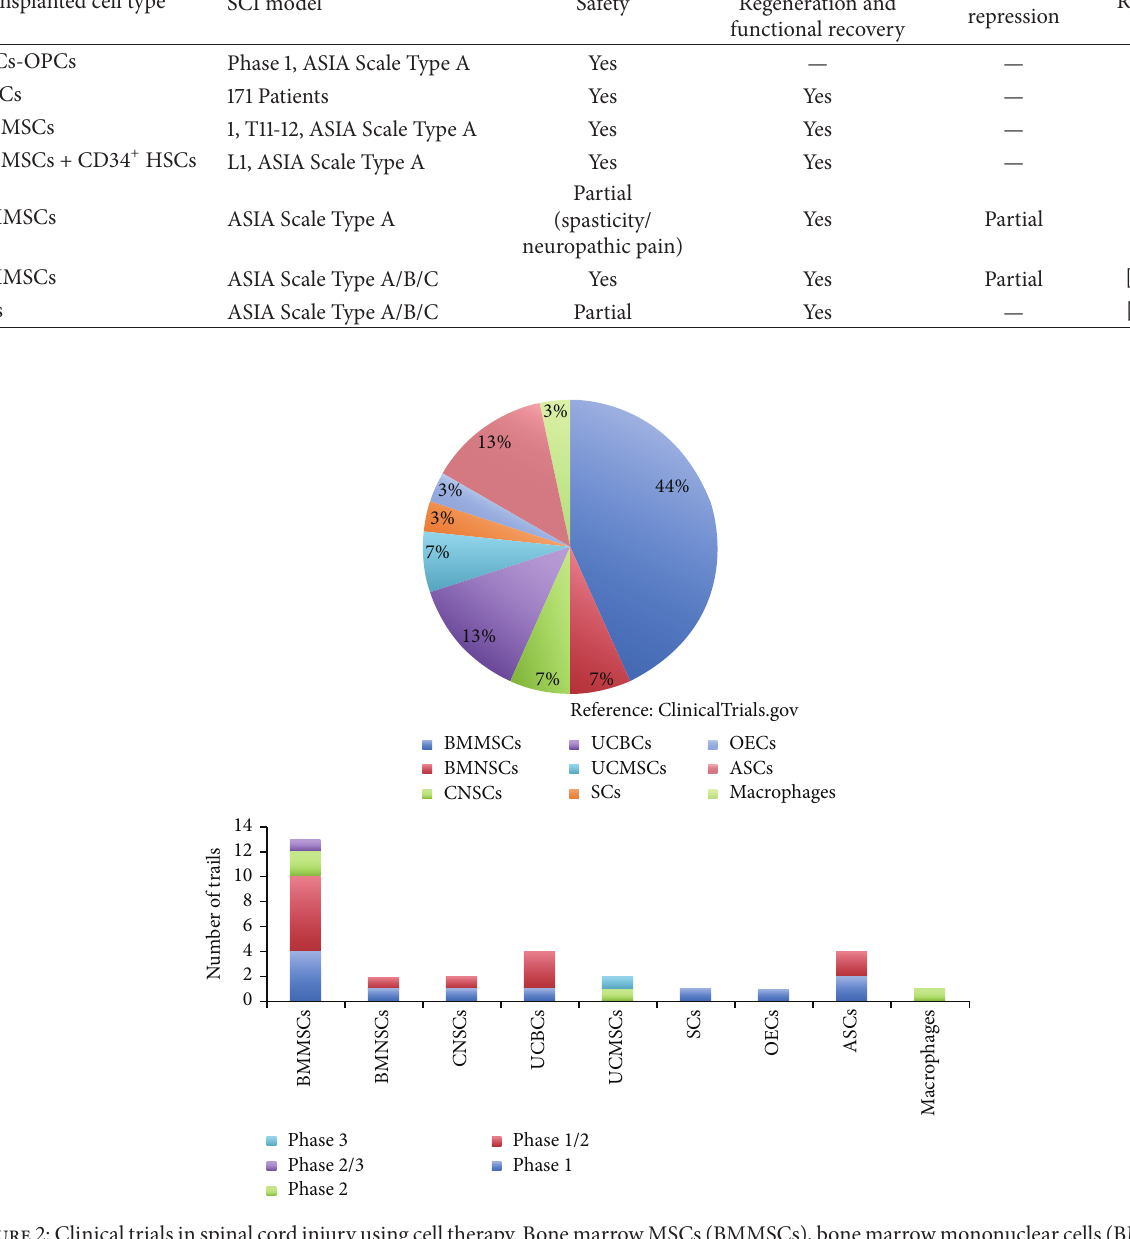
Figure 2: Clinical trials in spinal cord injury using cell therapy. Bone marrow MSCs (BMMSCs), bone marrow mononuclear cells (BMNSCs), central nervous system cells (CNSCs), umbilical cord blood cells (UCBCs), umbilical cord blood MSCs (UCBMSCs), Schwann cells (SCs), olfactory ensheathing cells (OECs), and adipocyte stem cells